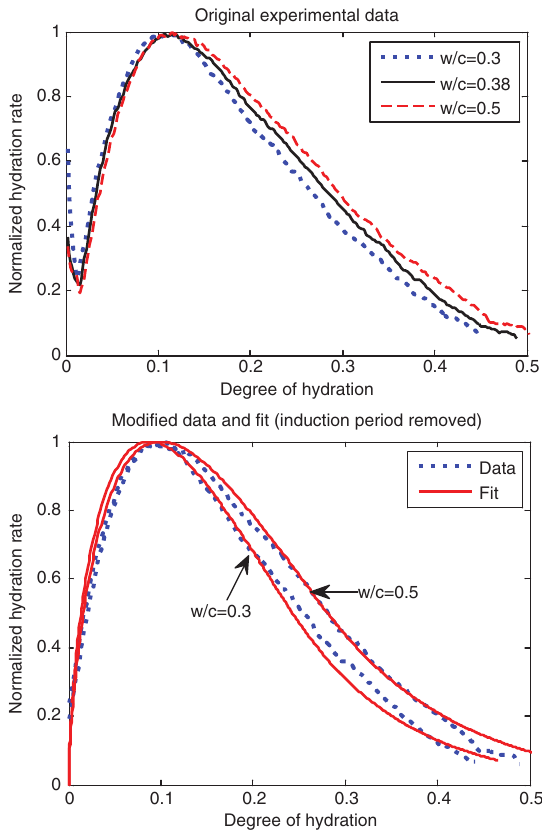
Figure 8: Experimental and modeled effect of w/c ratio on the hydration kinetics of cement.